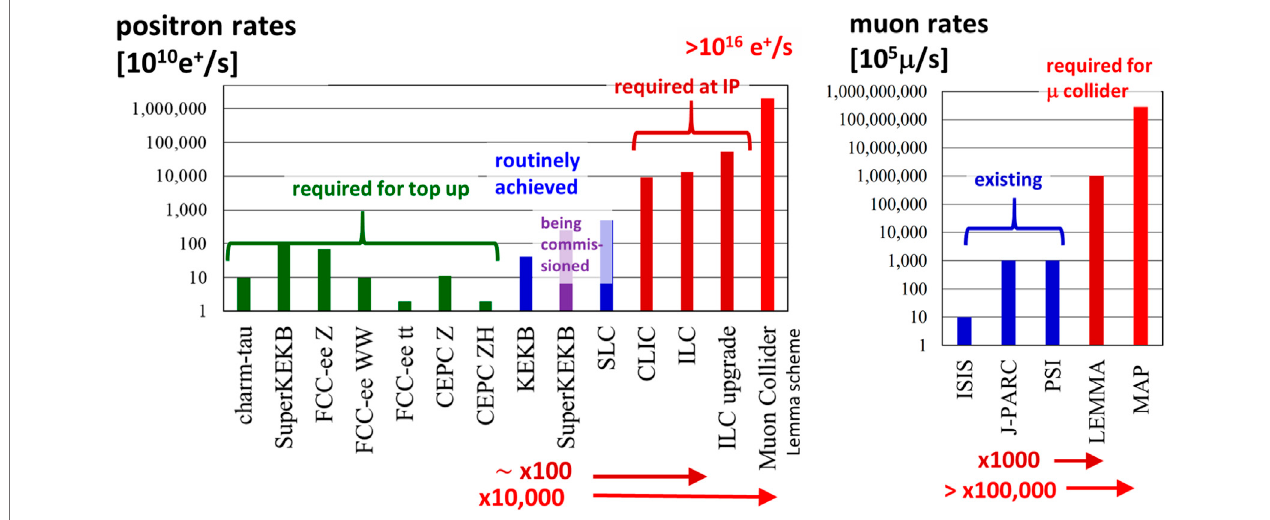
FIGURE 4 | Production rates of positrons at dedicated e + e − colliders [68] (left) and of muons at non-collider facilities [70] (right) presently achieved (blue) and required for various future collider projects (red, brown and green). Note the logarithmic scale on the vertical axes.